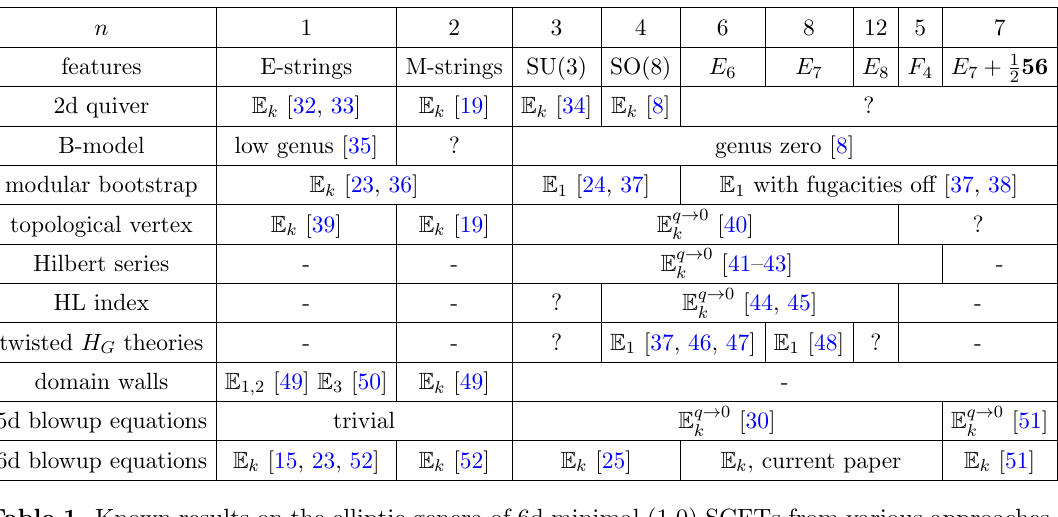
Table 1 . Known results on the elliptic genera of 6d minimal (1,0) SCFTs from various approaches. Here q = Q (cid:28) = e 2 (cid:25) i (cid:28) is the modular parameter. - means the method does not apply, and ? means possible applicable but results not yet attained. HL means